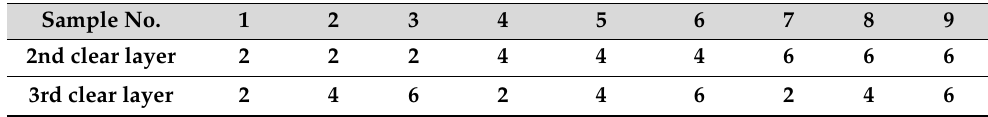
Table 1. Number of layers of each clear layer in the different samples. Sample